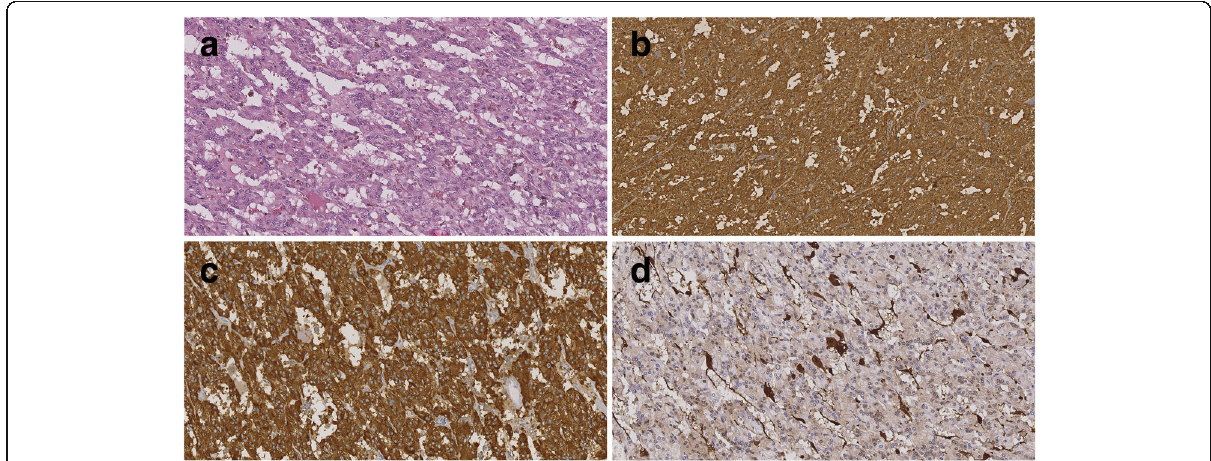
Fig. 2 a Histopathology - pheochromocytoma, tumor with a trabecular pattern of polygonal cells set in rich vascular network. Cells have finely granular cytoplasm, oval nuclei with prominent nucleoli and a coarsely clumped chromatin, without mitotic figures, HE staining, 200x. b Histopathology - pheochromocytoma, diffuse strong positivity of tumor cells, chromogranin, 200x. c Histopathology - pheochromocytoma, diffuse strong positivity of tumor cells, synaptophysin, 200x. d Histopathology - pheochromocytoma, positivity of the sustentacular cells at the periphery of the tumor cell clusters, S100 protein,